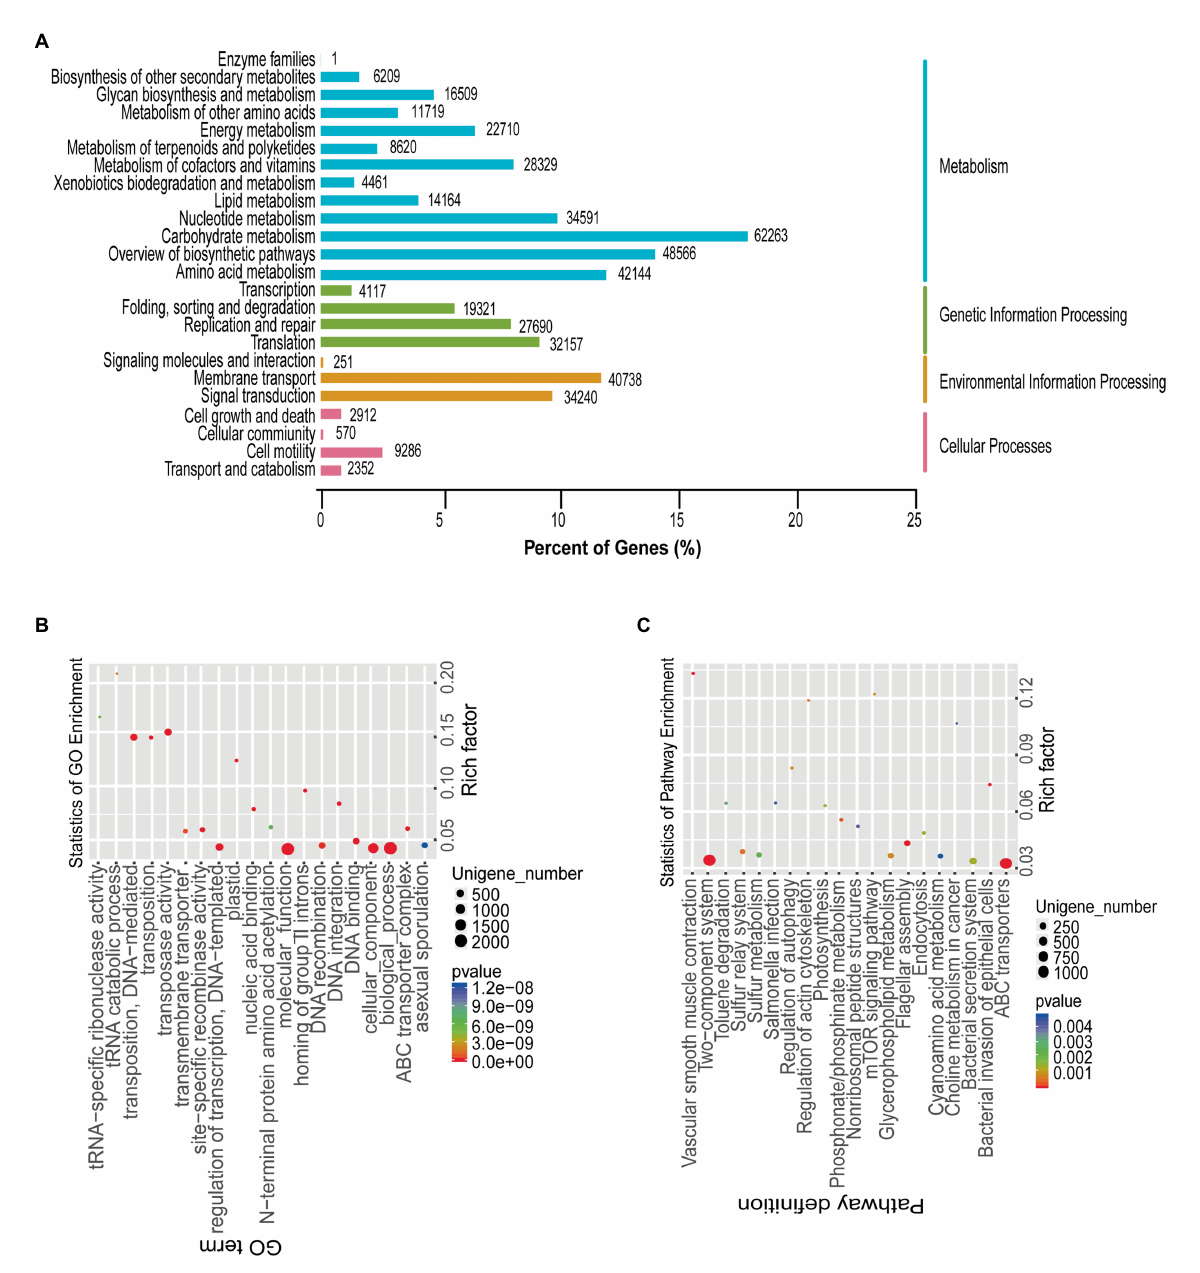
FIGURE 5 Functional annotation of gut microbiota. (A) KEGG pathway classification. The left and right vertical axes show the KEGG level 2 and KEGG level 1 classification information of KEGG PATHWAY, and the horizontal axis shows the percentage of annotated unigenes. (B) Differential gene enrichment analyzes. Scatter diagram of GO analysis results, using ggplot2 in R. Rich factor: number of differential genes with the GO term/total number of genes with the GO term. The larger the Rich factor, the higher the enrichment of the GO term. (C) Differential gene enrichment analyzes. Scatter diagram of KEGG analysis results, using ggplot2 in R. Rich factor: number of differential genes with the KEGG pathway/total number of genes with the KEGG pathway. The larger the Rich factor, the higher the enrichment of the KEGG